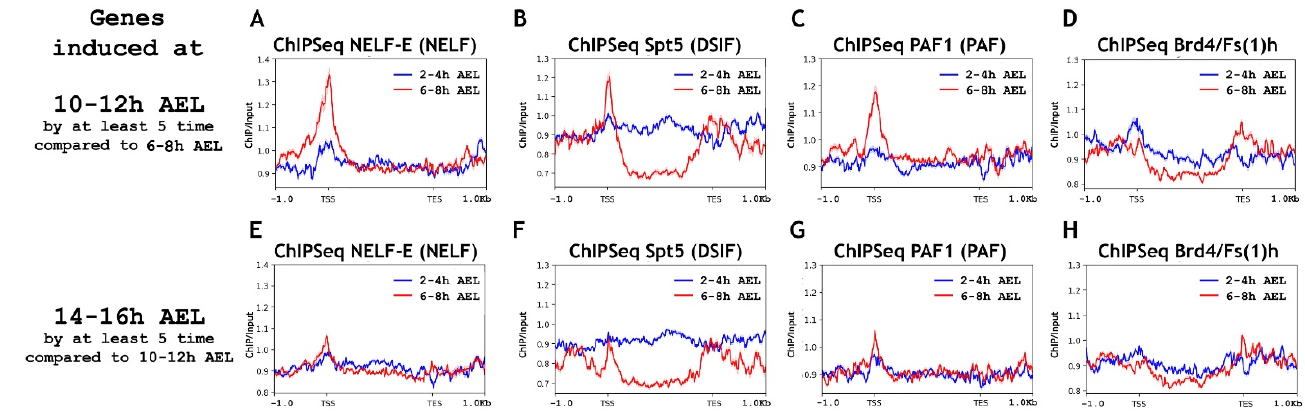
Figure 4. Average binding profiles of NELF-E (NELF), Spt5 (DSIF), PAF1 (PAF), and Bdr4/Fs(1)h on genes induced at the 10–12 h and 14–16 h AEL (after egg laying) stages of Drosophila embryogenesis. Average distribution of ( A ) NELF-E (NELF complex), ( B ) Spt5 (DSIF complex), ( C ) PAF1 (PAF complex), and ( D ) Brd4/Fs(1)h binding across the genes induced at 10–12 h AEL (after egg laying) of Drosophila embryogenesis (total 462 genes/1188 transcripts). Average distribution of ( E ) NELF-E (NELF complex), ( F ) Spt5 (DSIF complex), ( G ) PAF1 (PAF complex), and ( H ) Brd4/Fs(1)h binding across the genes induced at 14–16 h AEL (after egg laying) of Drosophila embryogenesis (total 548 genes/1379 transcripts). ChIP-Seqs were performed on whole embryos of 2–4 h (blue line) and 6–8 h (red line) after eggs laying (AEL). Pools of “10–12 h AEL genes” and “14–16 h AEL genes” were selected according to the common rule, to be induced at least five times compared with “6–8 h AEL” and “10–12 h AEL” stages, respectively. Protein binding levels were calculated as an enrichment (ratio of the corresponding ChIP-Seq signal to the input DNA). Average profiles were generated using the metagene mode (introns were ignored and gene bodies were scaled to 2 kb) and calculated as the median of the protein binding signal. Average profiles of the RNA-seq signal were calculated as the mean level. The standard error appears on the graphs as a lighter area around the main line of the profiles. Abbreviations: TSS: transcription start site; TES: transcription end site.